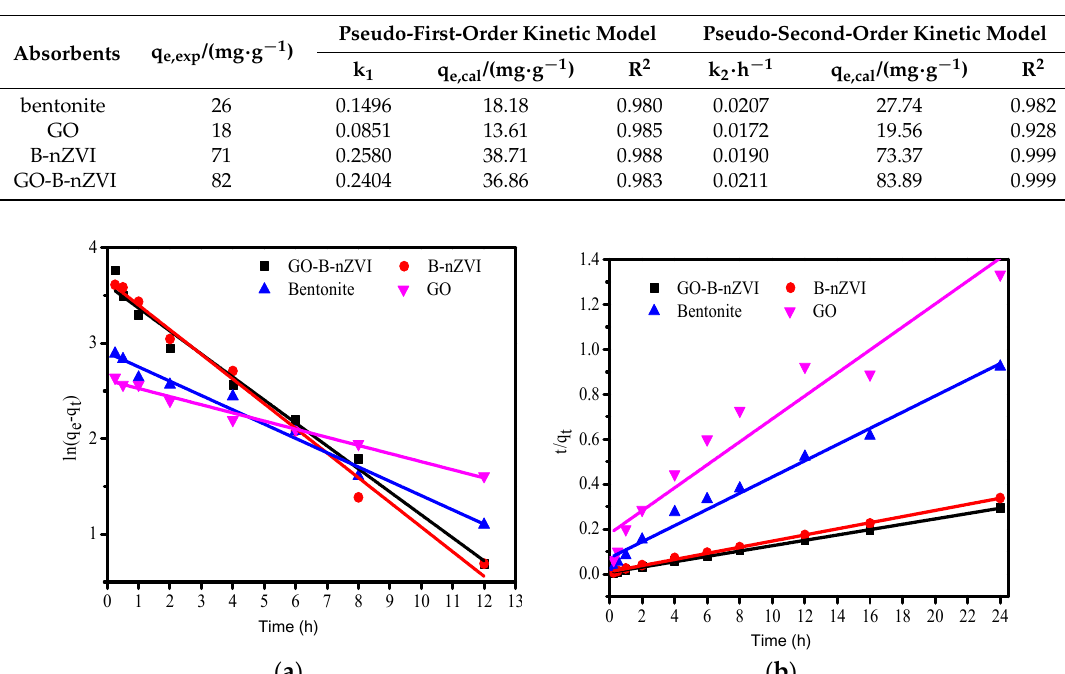
Figure 10. The pseudo first-order kinetic curve: ( a ) and pseudo-second-order kinetic and ( b ) curve of bentonite, GO, B-nZVI, and GO-B-nZVI for Cu(II) absorption.